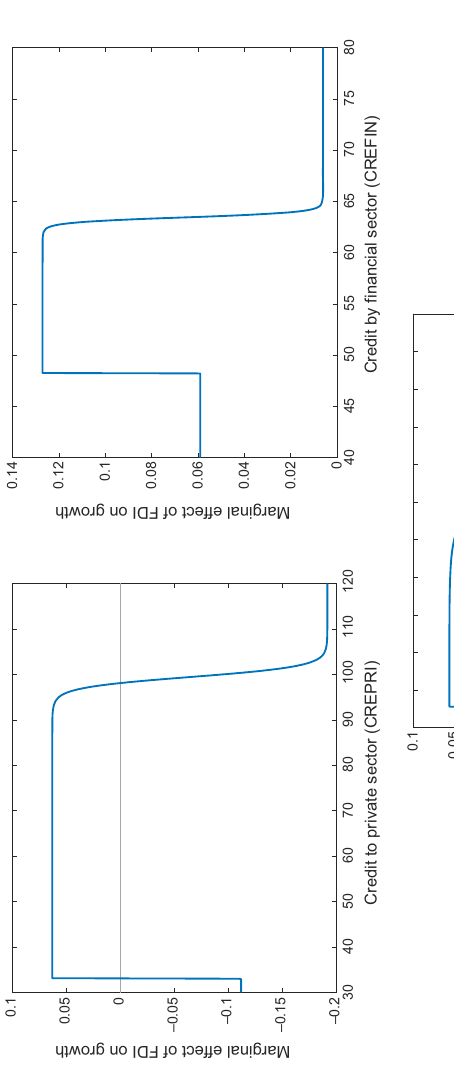
Figure 1. Marginal effect of FDI on economic growth conditional on financial